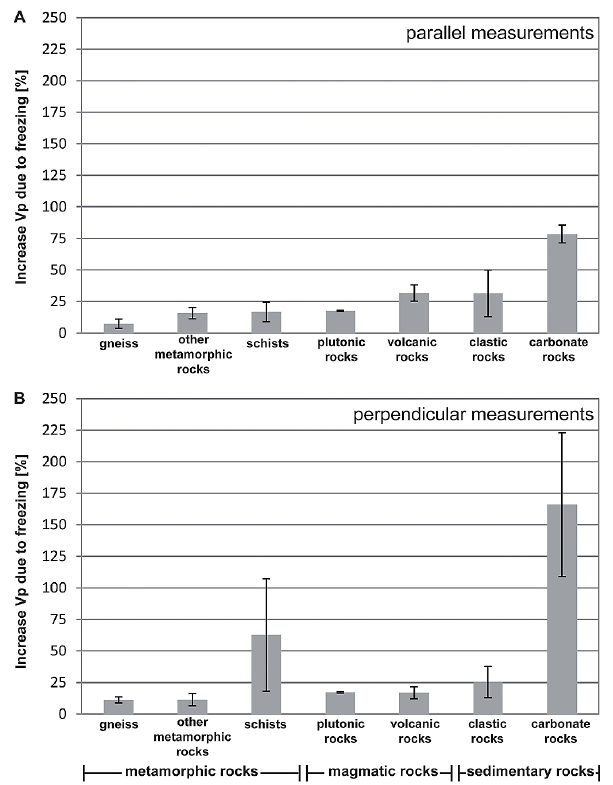
Fig. 4. P-wave velocity ( v p ) increase due to freezing plotted against mean effective porosities for six different rock groups. P-wave ve- locity increases (A) parallel to cleavage or bedding and (B) perpen- dicular to cleavage/bedding, the dots are measured values and the quadrats are values calculated using Eq.